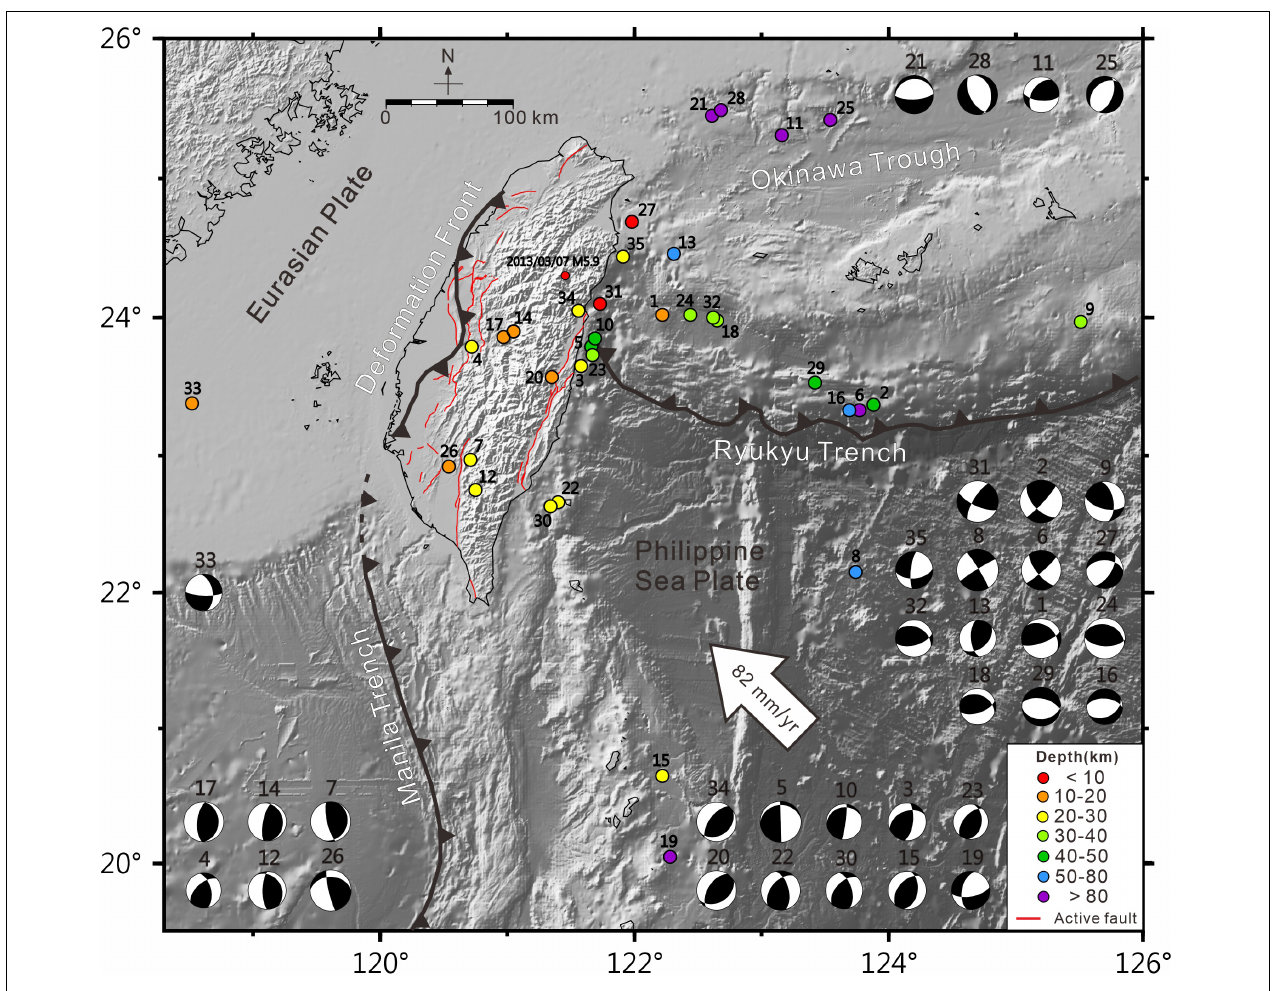
FIGURE 1 | A regional map and the principal tectonic structures around Taiwan showing the Philippine Sea Plate moving northwest at ∼ 82 mm/yr toward the Eurasian Plate (Yu et al., 1997). The circles represent M ≥ 6 earthquake epicenters from 2009 to 2019 with the colors corresponding to different focal depths. These earthquakes are labeled and listed in Table 1 . The red lines indicate the active faults of